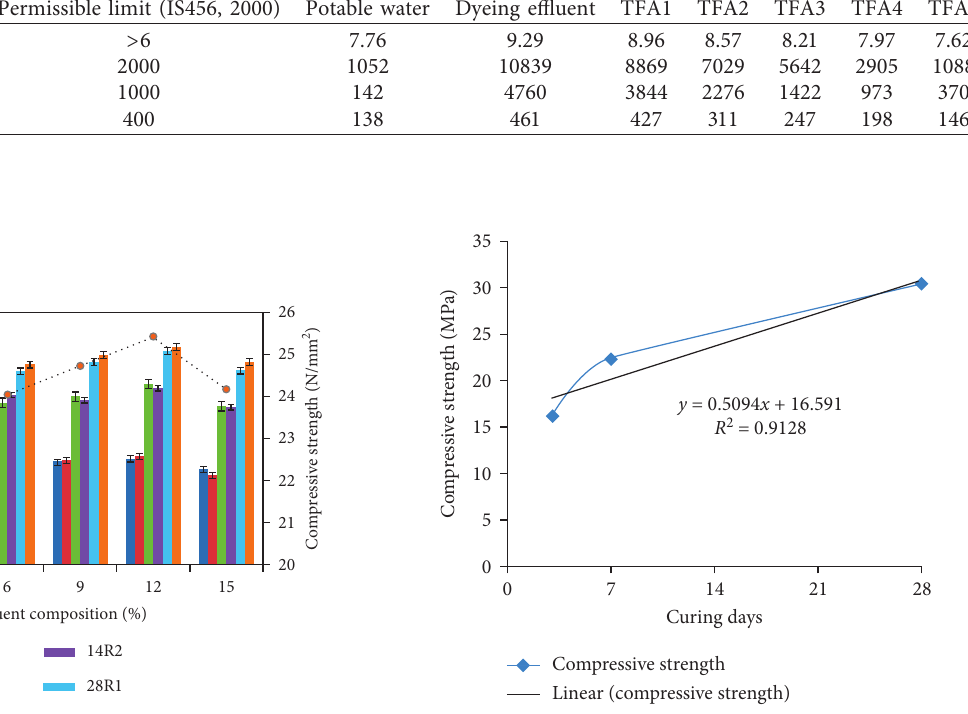
Figure 3: Temporal variations in compressive strength of the conventional concrete block. Figure 2: Compressive strength of dye